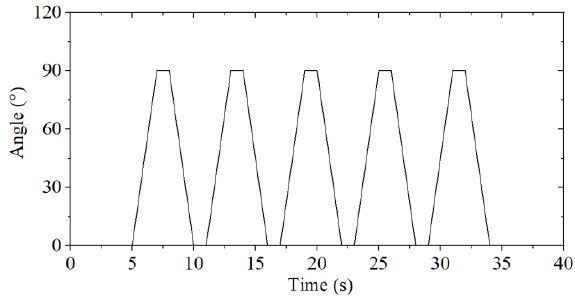
Figure 15. Change of rotation angle of shoulder yaw joint